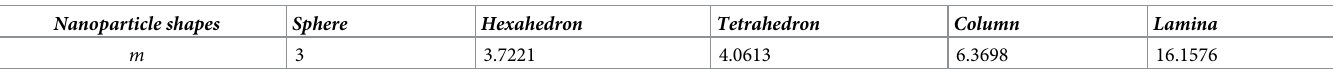
Table 2. Values of empirical shape factor for different particle shapes. Nanoparticle